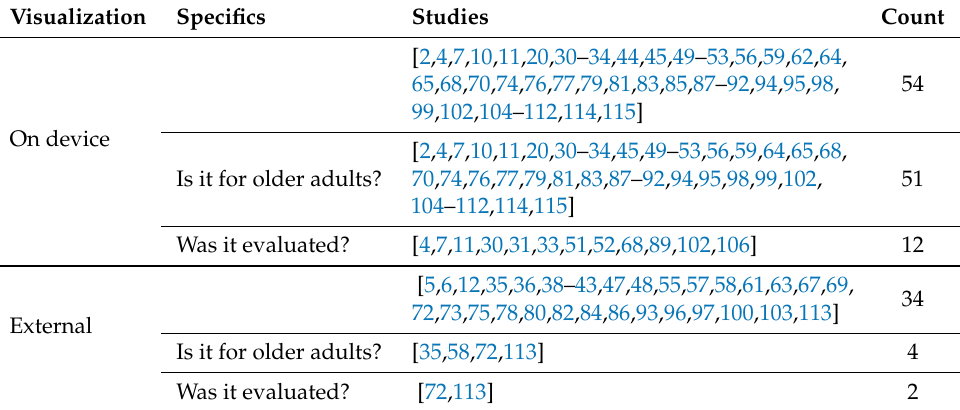
Table 6. Visualization of older adults’ health data—specifications, studies, and